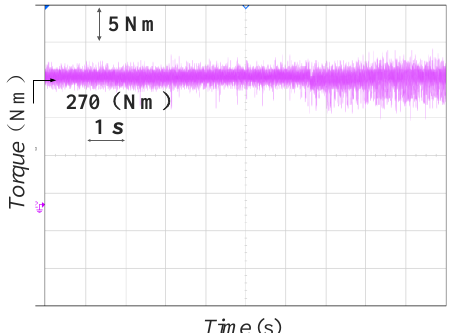
Figure 13. Measured torque under 5.7 A/mm 2 current density @ 600 r/min.